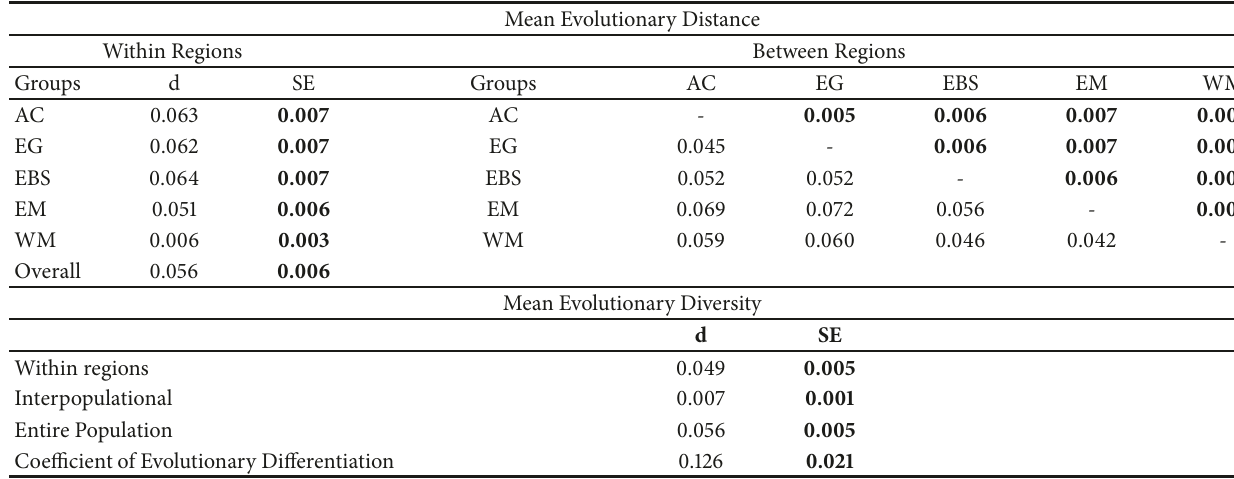
Table 3: Estimates of average evolutionary divergence over sequence pairs of the CP genes of CTV isolates from different citrus growing regions of Turkey.